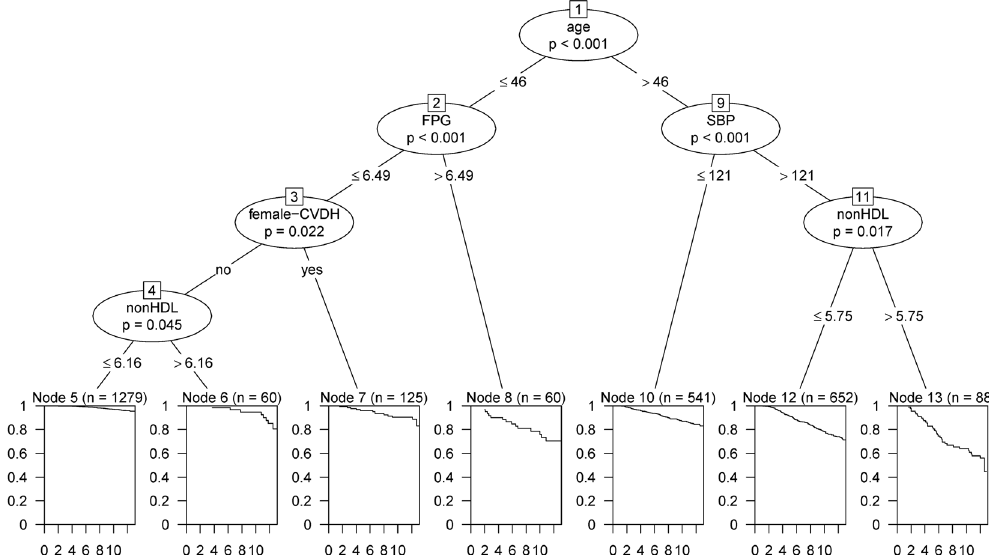
Figure 1. Survival tree model for incidence of CHD events in men and the distribution of survival times in the terminal nodes, Tehran Lipid and Glucose Study (1999–2012). At each level, the most significant split based on log-rank (LR) and permutation P value is shown. SBP : Systolic blood pressure; FPG : Fasting plasma glucose; female-CVDH : Family history of CVD in female